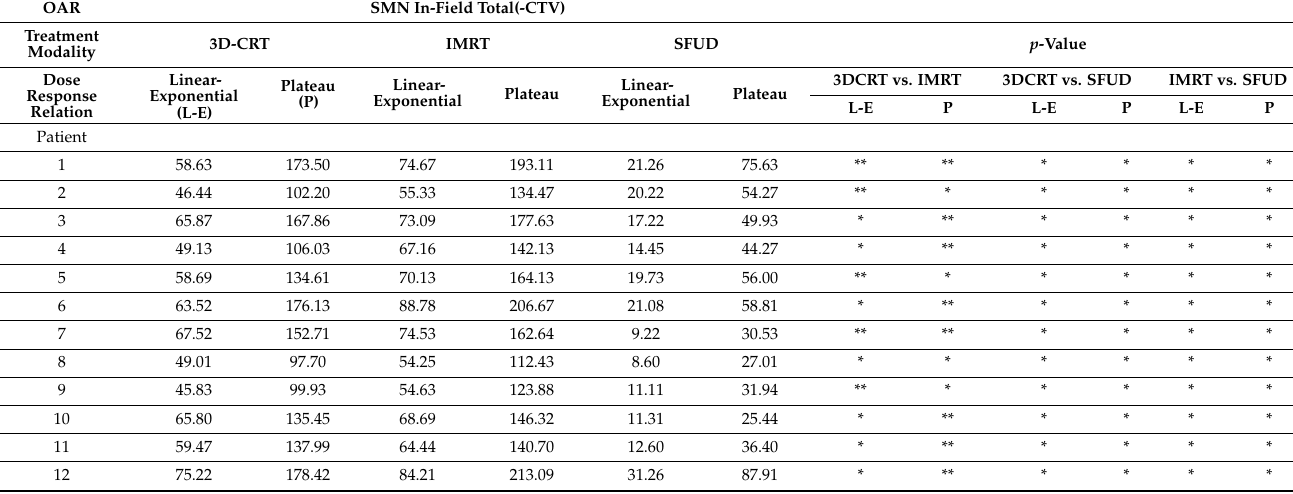
Table 7. Total risk of SMNs (excess absolute risk per 10,000 patients /year/Gy) for each patient, for each treatment modality, and dose response